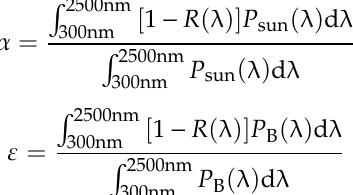
Table 1. Optimized sputtering process parameters for the Cu / Ti x Si y N / AlSiN tandem absorber. Flow Rate (sccm) Sputtering Layer (nm)Ar N 2 Cu